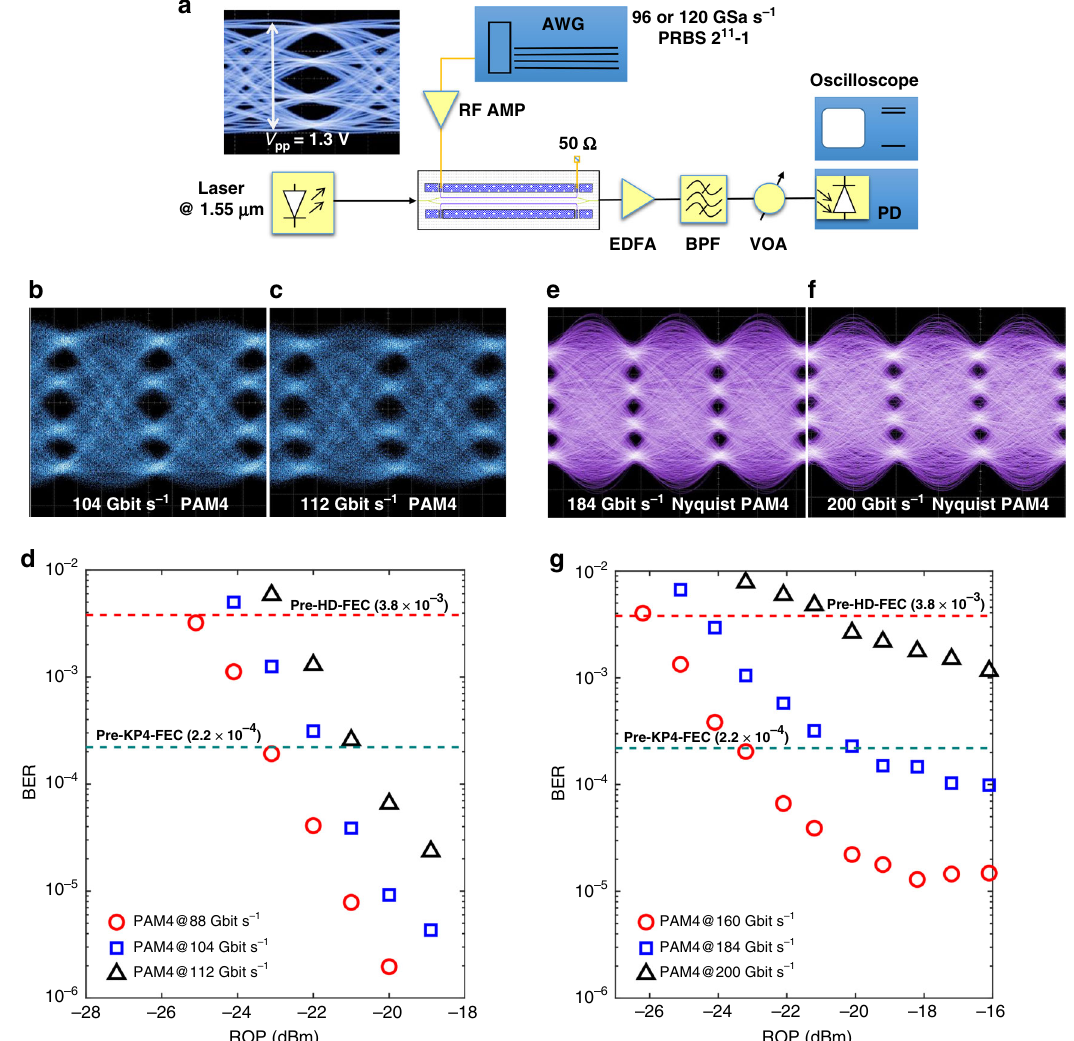
Fig. 3 Up to 200 Gbit s − 1 PAM4 signalling. a Experimental setup for generating PAM4 signals from our fabricated SPH modulator. AWG arbitrary waveform generator. Inset shows the driving electrical PAM4 signals with a peak-to-peak voltage of 1.3 V. b , c Measured optical eye diagrams of PAM4 signals at data rates of 104 Gbit s − 1 ( b ) and 112 Gbit s − 1 ( c ). d Measured BER curves as functions of the received optical power for 88, 104, and 112 Gbit s − 1 PAM4 signals. e , f Measured optical eye diagrams of Nyquist PAM4 signals at data rates of 184 Gbit s − 1 ( e ) and 200 Gbit s − 1 ( f ). g Measured BER curves as functions of the received optical power for 160, 184, and 200 Gbit s − 1 Nyquist PAM4 signals. The pre-FEC BER thresholds for hard-decision (HD) and KP4 FECs 42 , that is, 3.8 × 10 − 3 and 2.2 × 10 − 4 , respectively, are plotted for